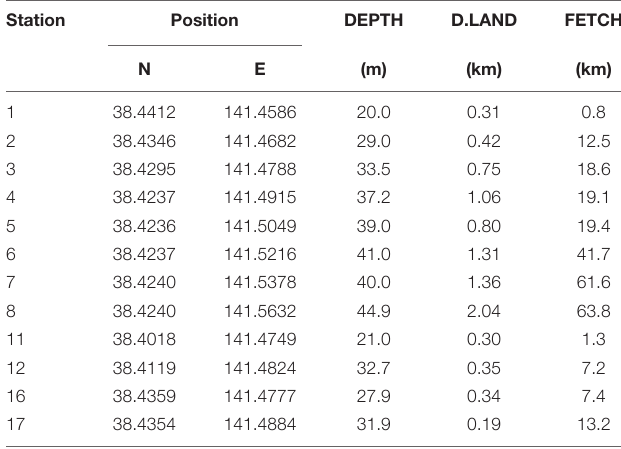
TABLE 2 | Description of sampling stations for the Onagawa Bay Monthly Survey (DEPTH, D.LAND, and FETCH as in Table 1 ).